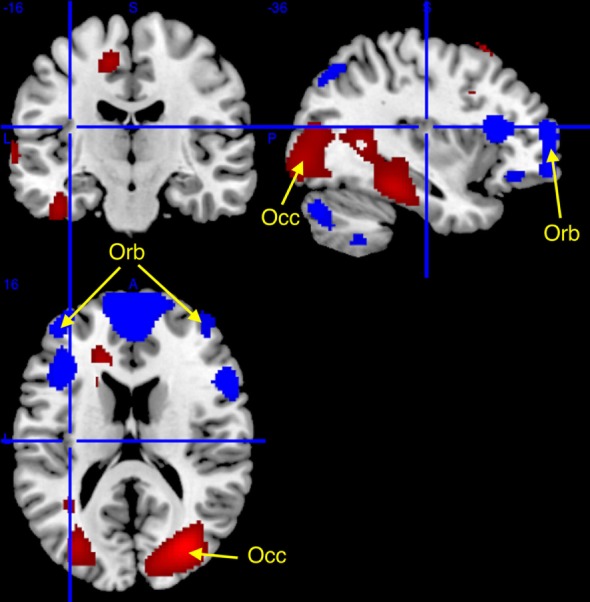
Higher (red) and lower (blue) regional cerebral glucose consumption in narcolepsy type 1 as compared to idiopathic hypersomnia, superimposed on a template T1-weighted magnetic resonance image. Higher metabolism (at punc < 0.001, cluster >50 voxels; see arrows) was found in narcolepsy in the superior occipital cortex (Occ) and lower metabolism was found bilaterally in the middle orbital gyrus (Orb) and in the supplementary motor area (not displayed). Other activations are displayed for the sake of completeness at punc < 0.05 uncorrected threshold, for clusters > 50 voxels.